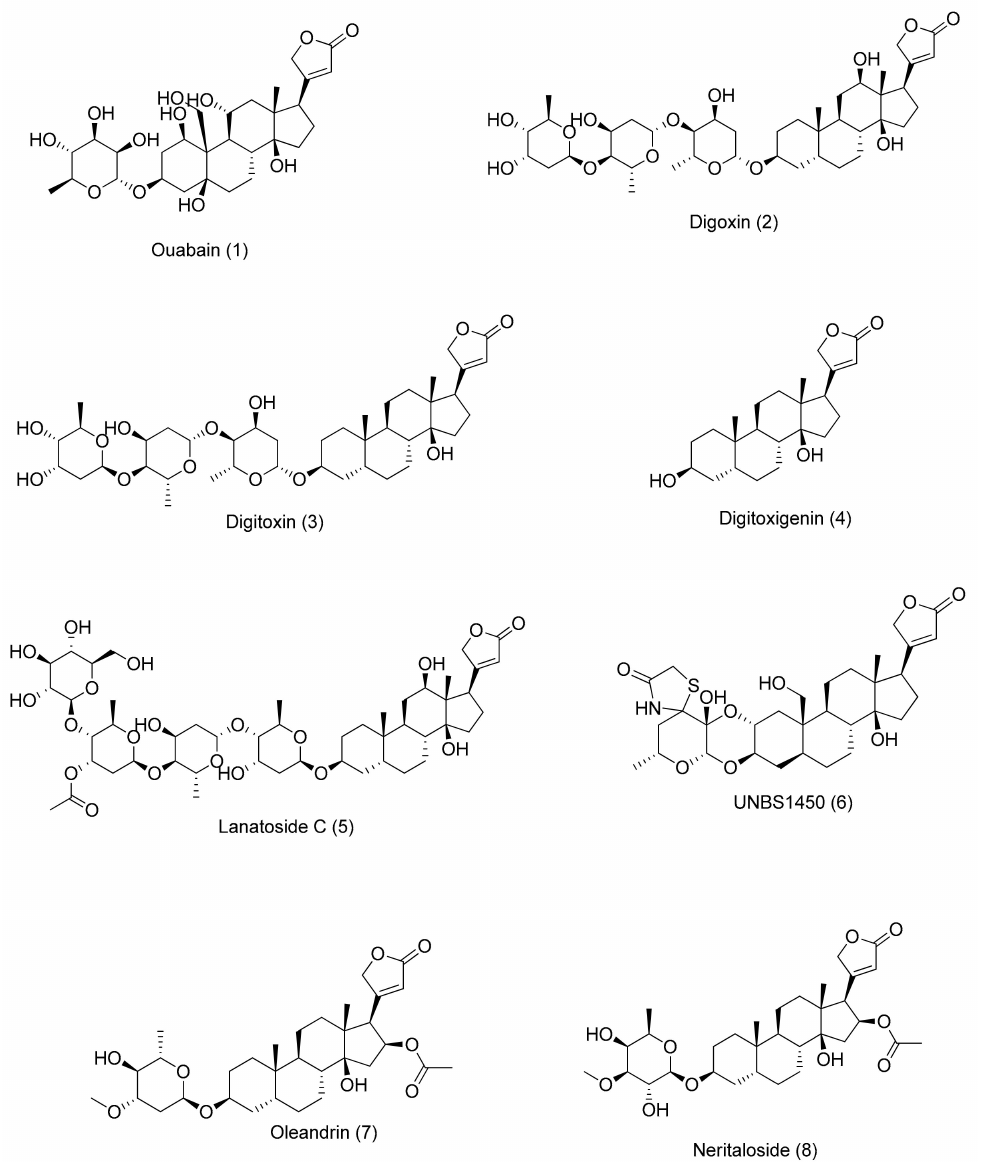
Figure 1. Molecular structures of cardenolides, as described in the text. Each molecule is numbered in order of its appearance in the